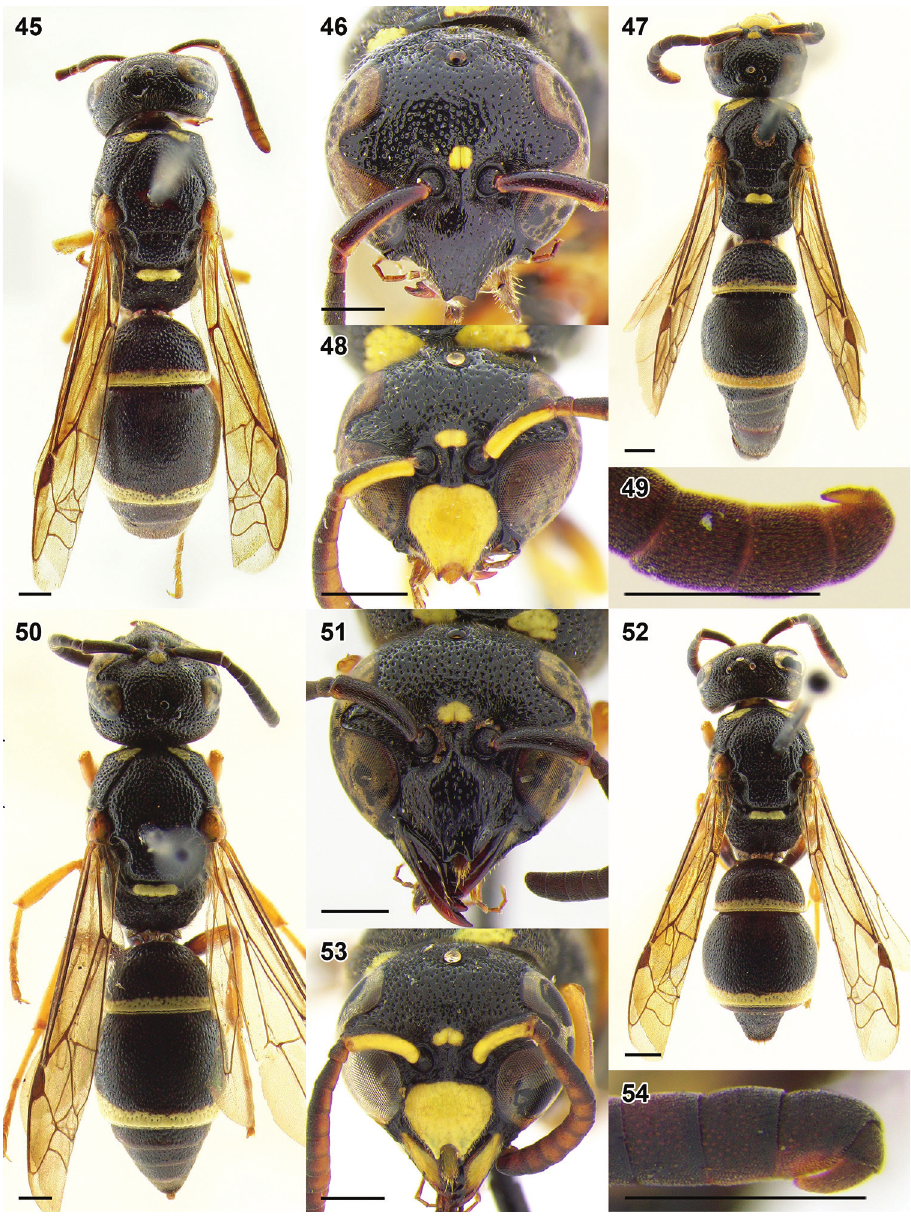
Figures 45–54. Stenodynerus pullus Gusenleitner, 1981, paratype, female, Russia (Primorskiy Terr.) ( 45–46 ), S. pullus , male, Russia (Primorskiy Terr.) ( 47–49 ), S. orenburgensis (André, 1884), female, Rus- sia (Crimea) ( 50, 51 ), and S. orenburgensis , male, Russia (Crimea) ( 52–54 ) 45, 47, 50, 52 dorsal habitus 46, 48, 51, 53 head in frontal view 49, 54 apex of antenna. Scale bars 0.5